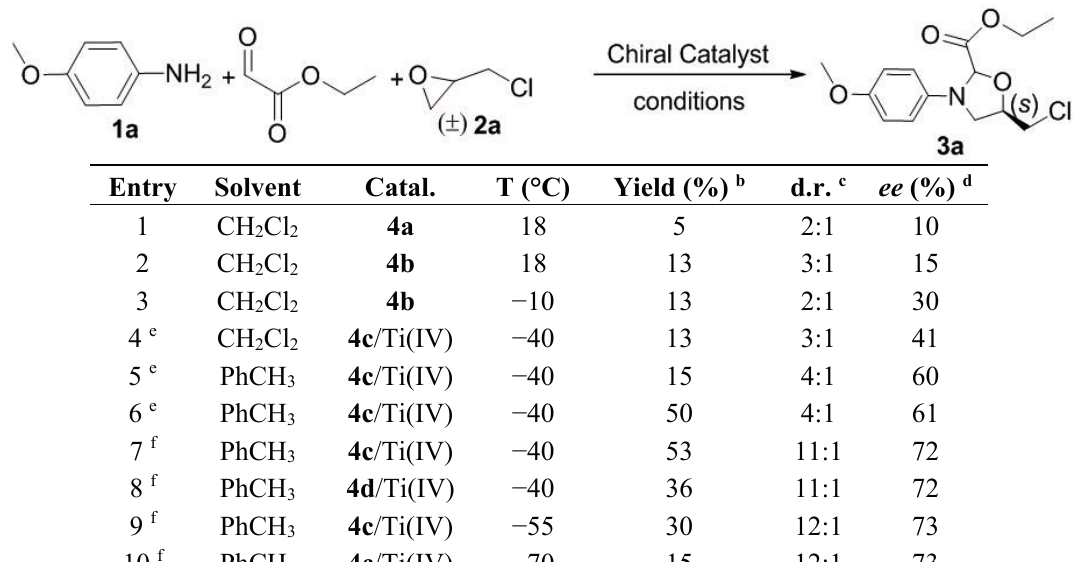
Table 1. Catalyst screening and optimization of the three-component reactions a